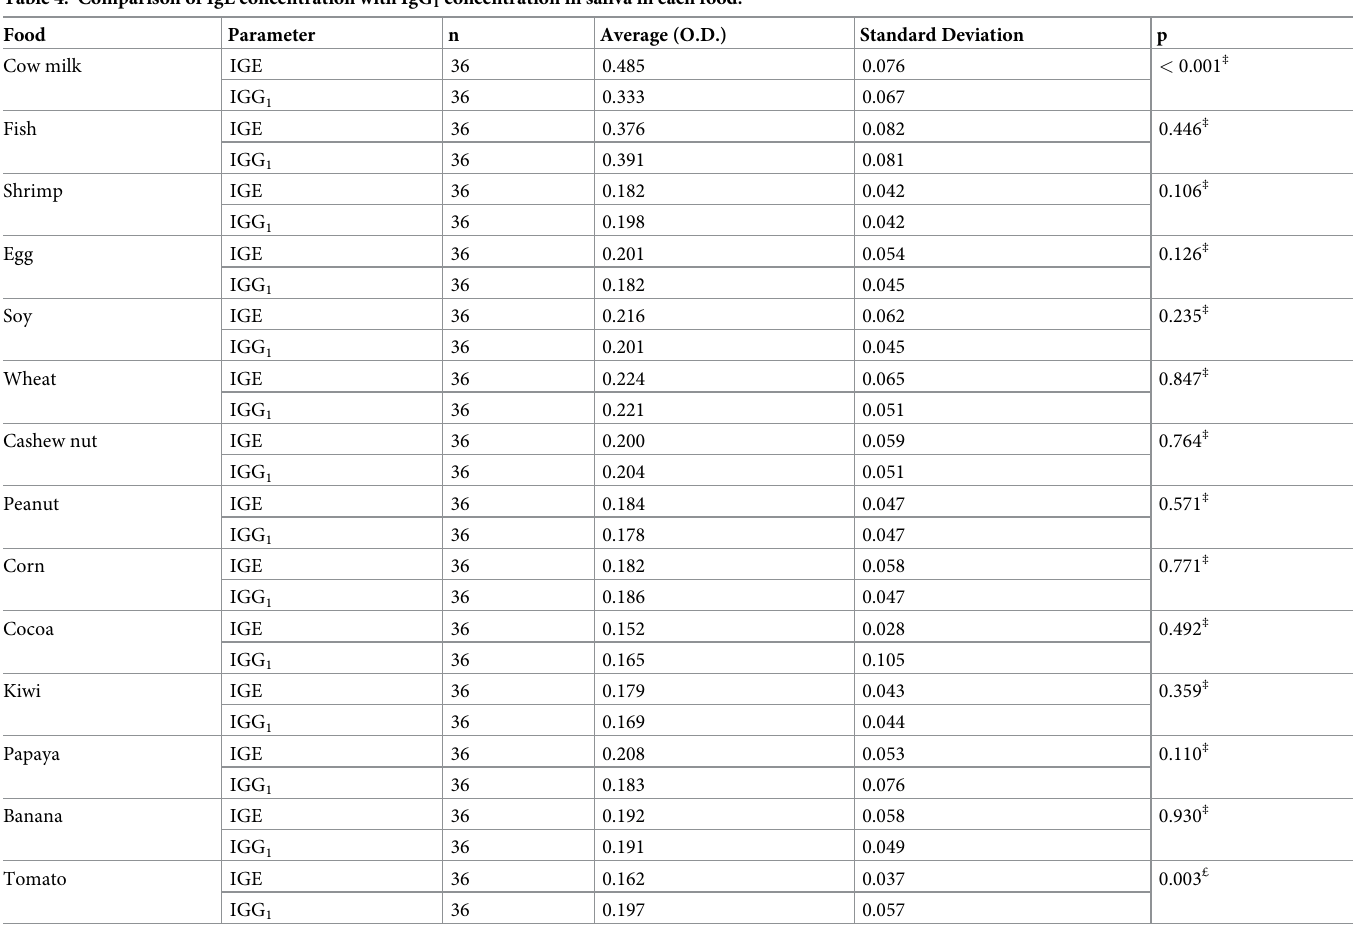
Table 4. Comparison of IgE concentration with IgG 1 concentration in saliva in each